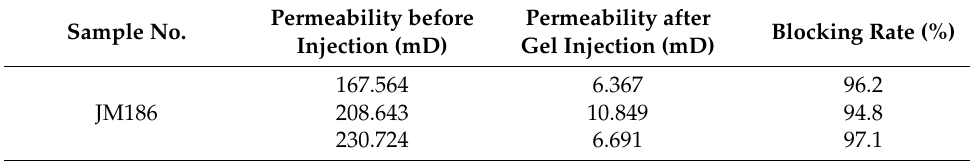
Table 5. The water-blocking results of the JM186 gel system. Sample